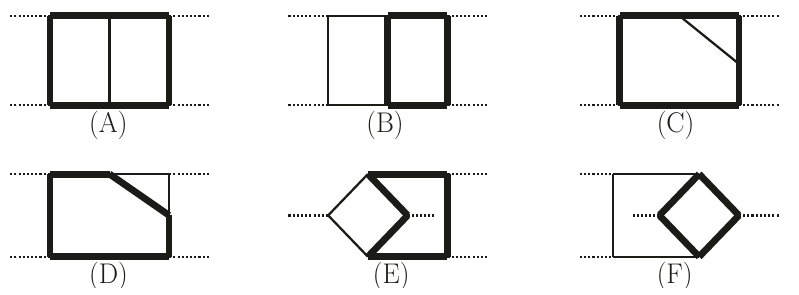
Figure 3 . Left side: the partonic total cross section as a function of momentum distribution of the Higgs boson at the parton level with